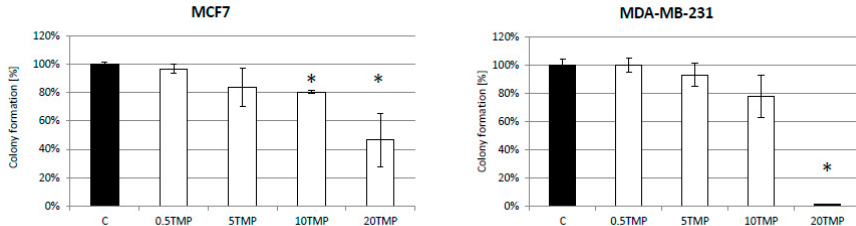
Figure 4. TMPyP4 reveals a genotoxic effect. Colony formation assessment was performed after 72 h treatment with TMPyP4 (0.5, 5, 10 or 20 µM) followed by 10 days of culture. The cells were seeded on